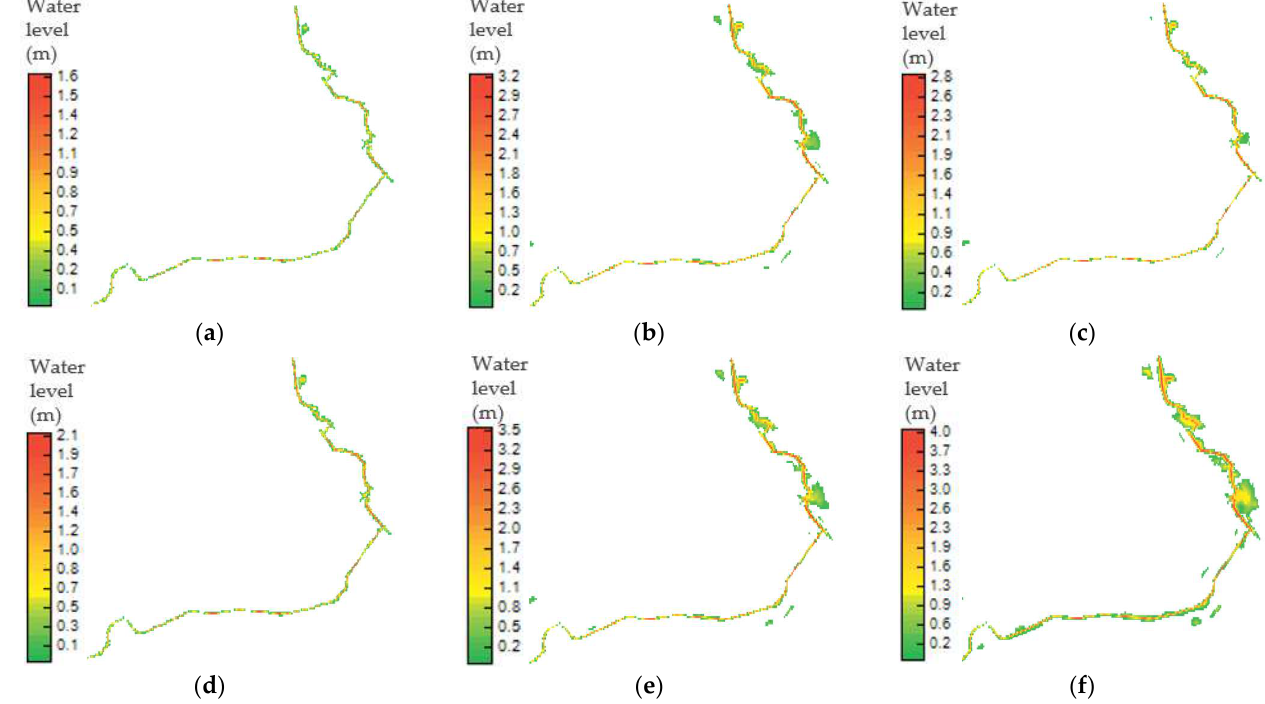
Figure 12. Illustrative example of stochastic flood scenarios for the climatic scenario RCP 2.6 and the short-term period for the return periods of ( a ) 2 years; ( b ) 5 years; ( c ) 10 years; ( d ) 25 years; ( e ) 50 years; ( f ) 100 years.